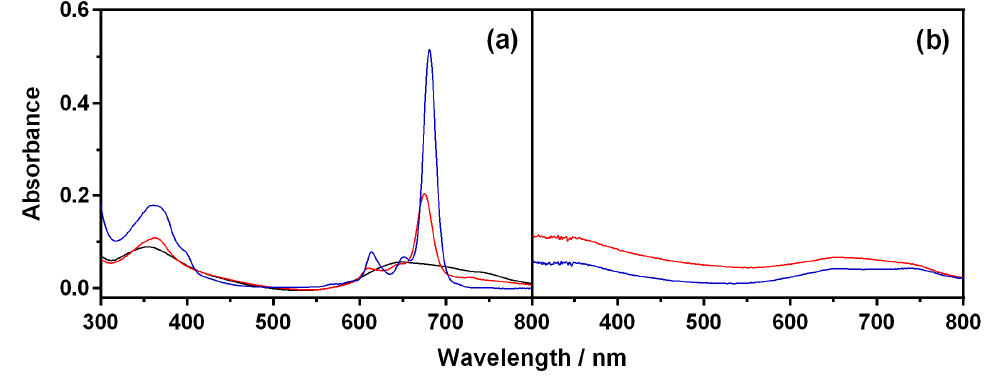
Figure 1. ( a ) Absorbance spectrum of ZnPcOBP in toluene (blue), acetonitrile (red), and methanol (black); ( b ) Absorbance spectra of MSNP3 (blue) and MSNP4 (red) in methanol.